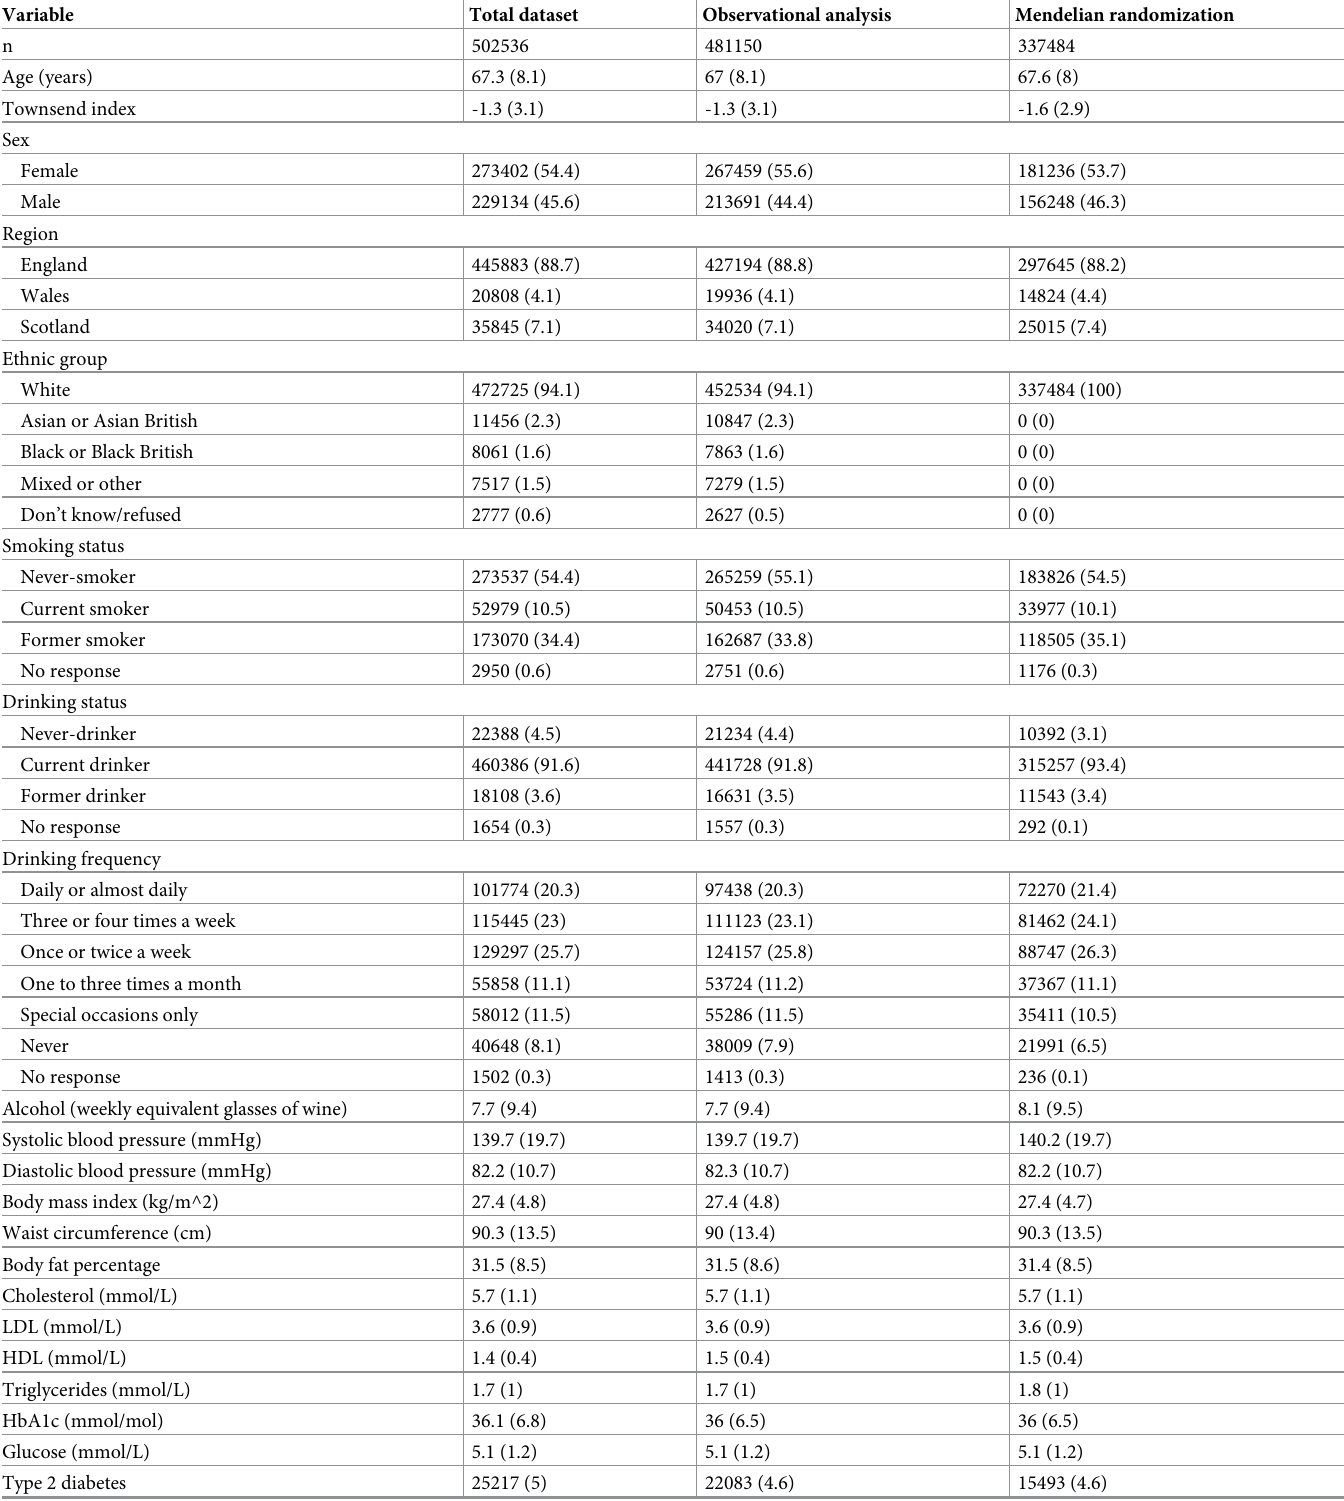
Table 1. Summary of characteristics of UK Biobank participants by analysis